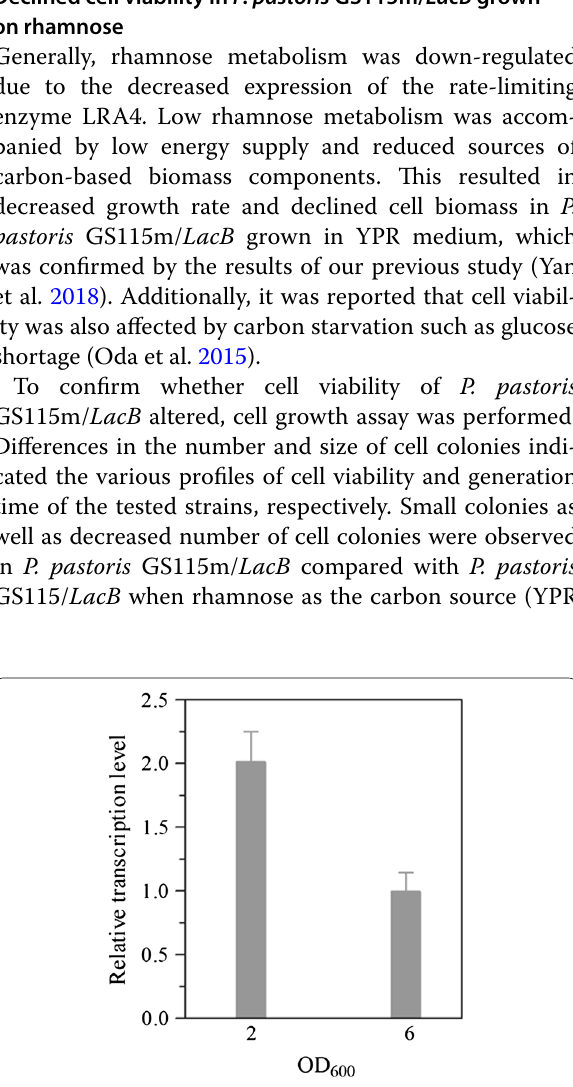
Fig. 4 Relative transcription levels of LacB in P. pastoris GS115m/ LacB grown in YPR medium. The P. pastoris GS115m/ LacB strain was grown in liquid YPR medium to an OD 600 of ~ 2 and ~ 6, respectively. The relative expression value of LacB in P. pastoris GS115/ LacB was used as the control and designated as